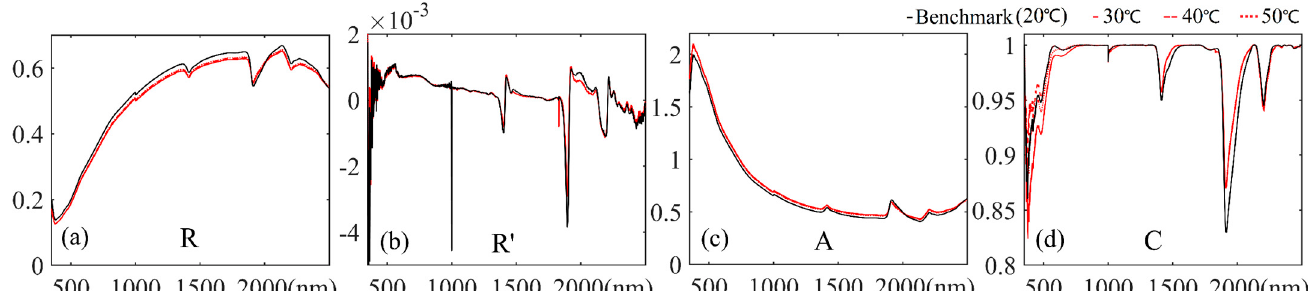
As explained in detail in Table 2, the model names in Table 3 correspond to: JLB: Jilin Benchmark (contact measurement); a, b, and c in model names refer to Darkroom 0.3 cm treatment, Illuminated 0.3 cm treatment, and